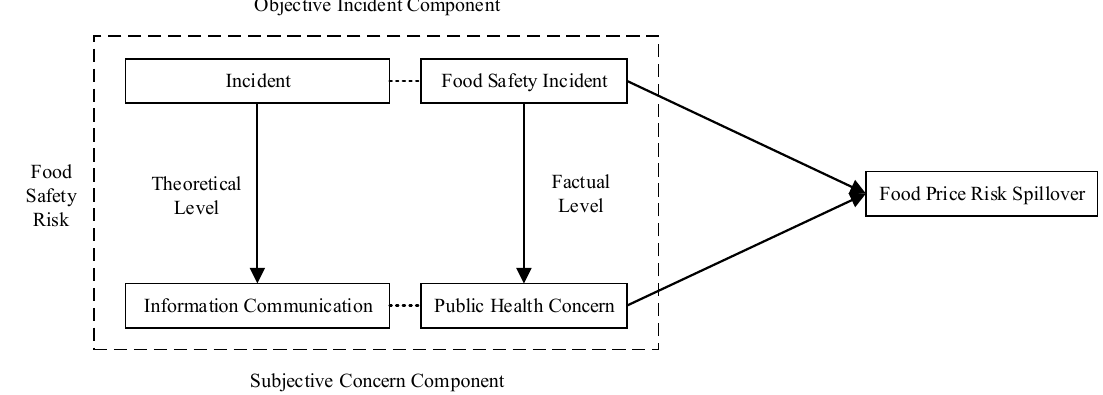
Figure 1. Conceptual framework of decomposition. Source: Originally developed by the authors.